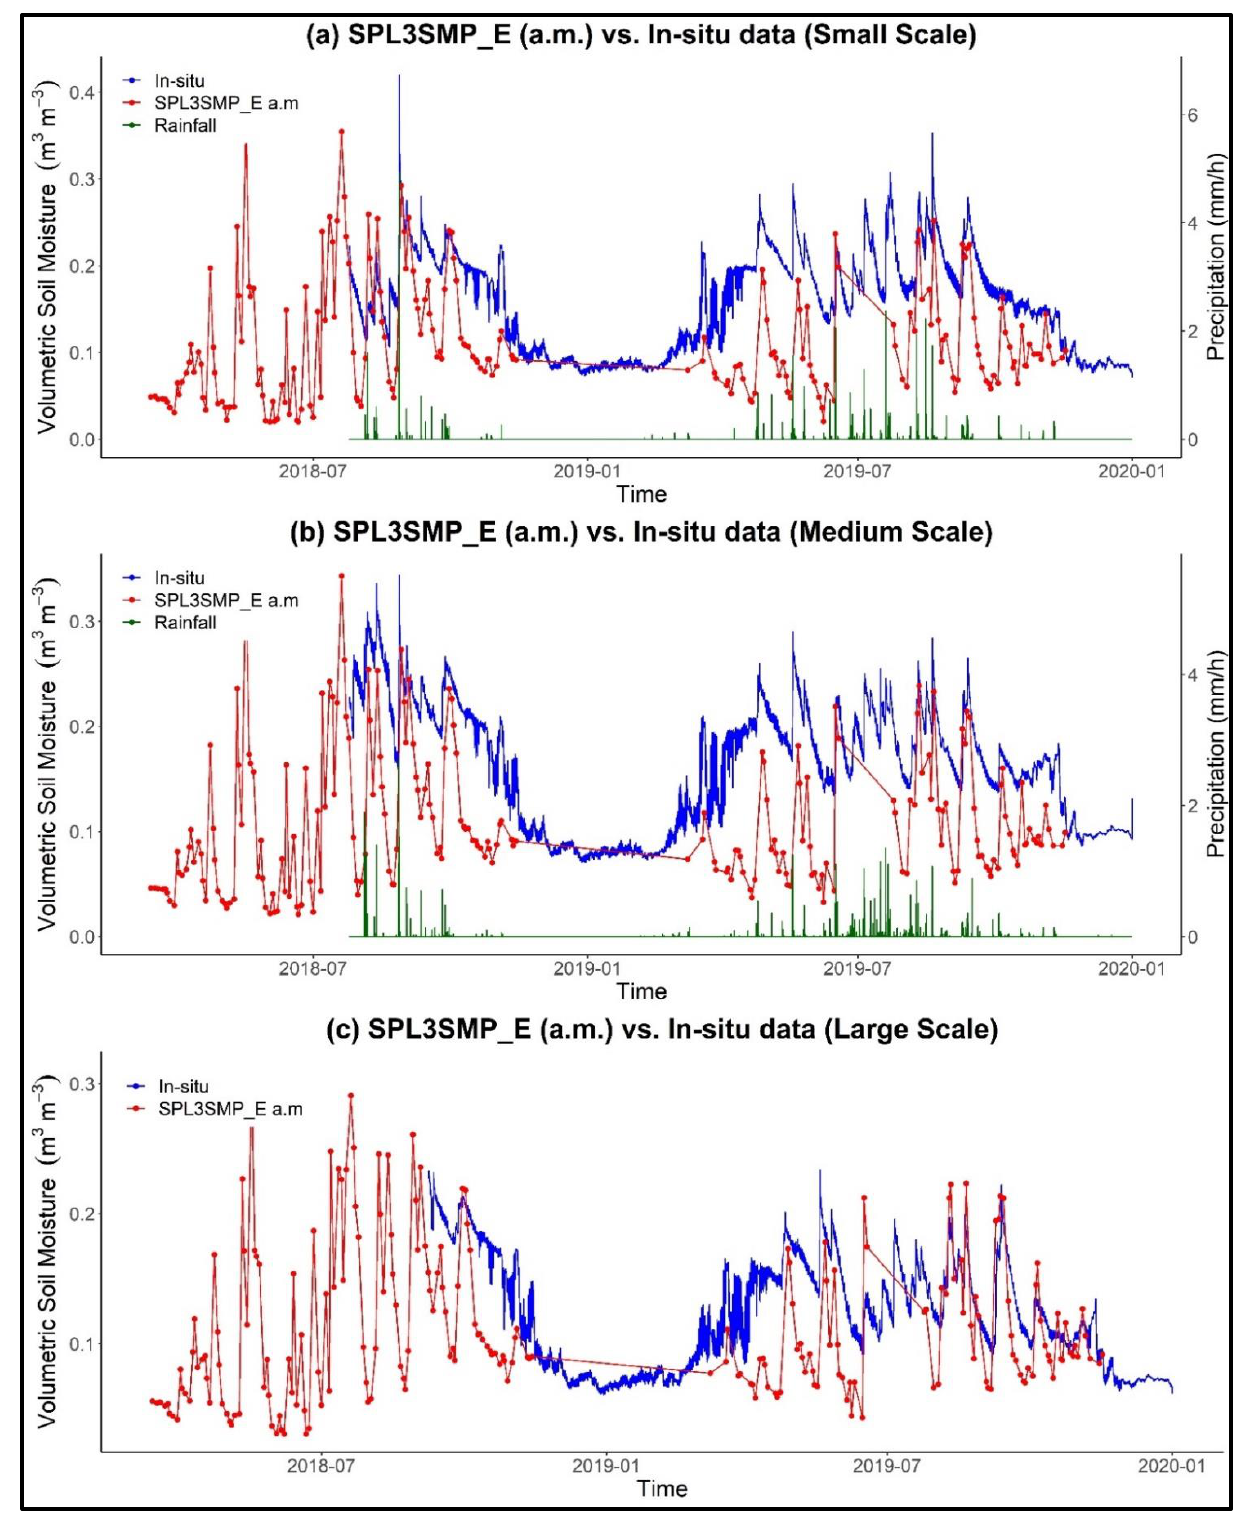
Figure 6. Comparison of SPL3SMP E (a.m.) SM and station averaged in situ data (hourly composite of SSM) at different spatial locations, ( a ) S-scale stations, ( b ) M-scale stations, ( c ) L-scale stations.